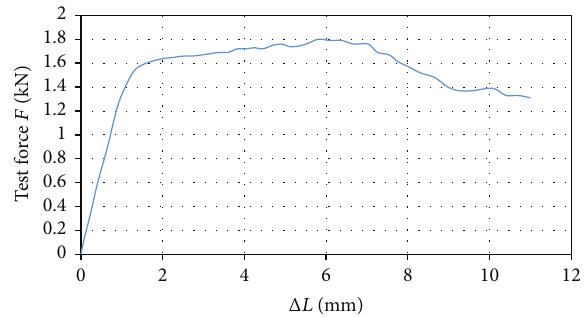
Figure 4: Force-elongation diagram.